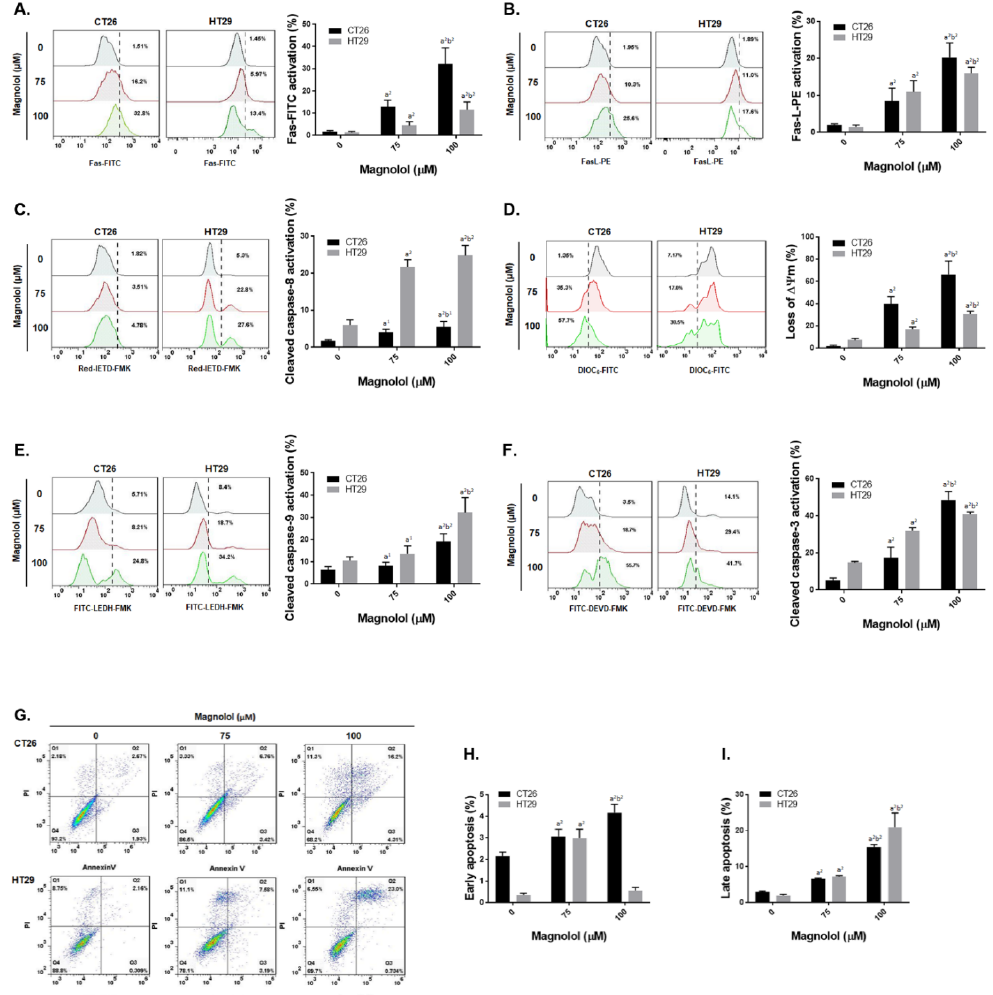
Figure 3. both death receptor and mitochondria dependent apoptosis effect is induced by magnolol in crc cells. The activation status of apoptosis markers including ( A ) Fas, ( B ) Fas-L, ( C ) cleaved caspase-8, ( D ) loss of ΔΨ m, ( E ) cleaved caspase-9 ( F ) cleaved caspase-3 ( G–I ) Annexin-V/PI has shown by one represented histogram pattern from each group and average repeated experiment chart. All experiments were performed in triplicate; each was repeated at least three times (a 1 p < 0.05 and a 2 p < 0.01 vs 0 μ M magnolol; b 1 p < 0.05 and b 2 p < 0.01 vs 75 μ M magnolol).